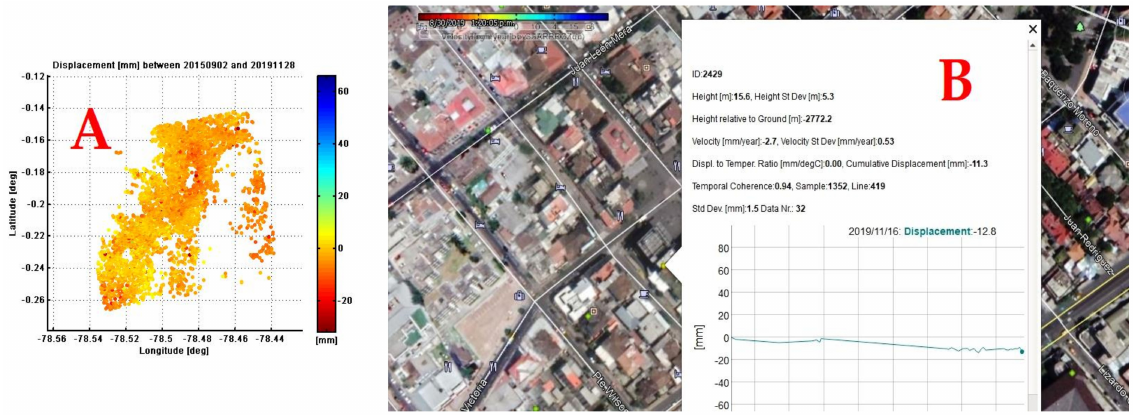
Figure 7. ( A ) Scatter plots of velocity for each point of the area. ( B ) Multi-time displacement and velocity analysis (2015–2019